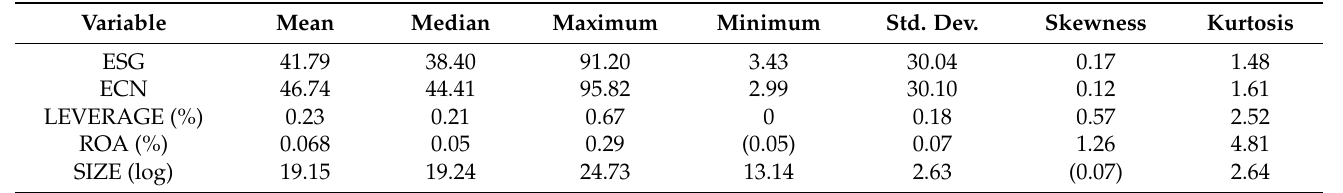
Table 3. Descriptive